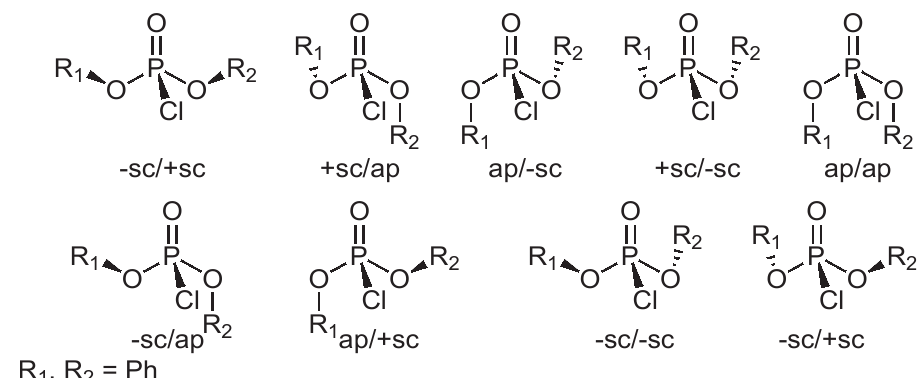
Figure 4. Conformer structures for diphenyl